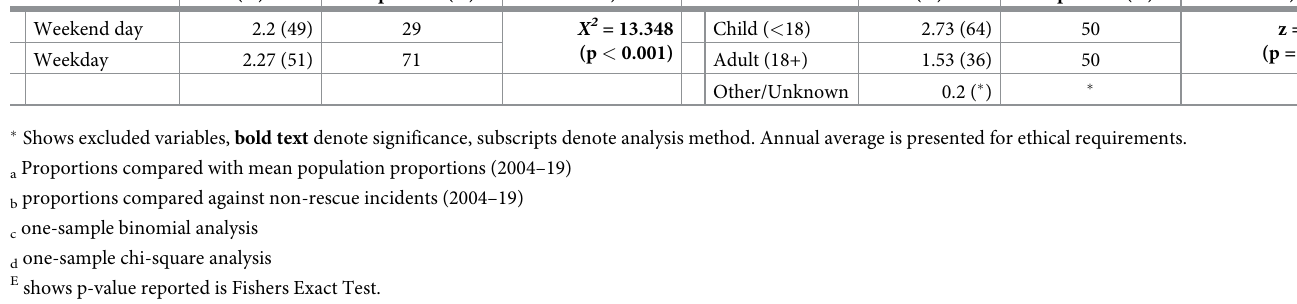
PLOS ONE | https://doi.org/10.1371/journal.pone.0238317 September 16,